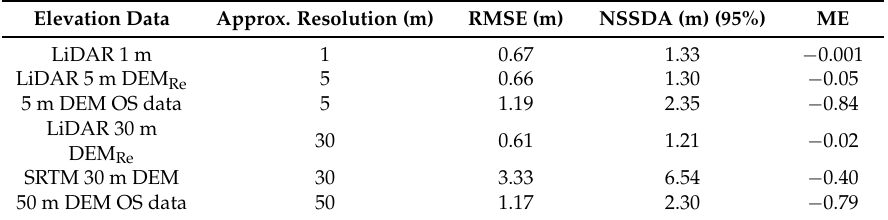
Table 1. Root mean square error (RMSE), national standard for spatial data accuracy (NSSDA) measurement of linear error (L.E.) with a 95% confidence level, and mean error (ME) for the different DEMs used in this